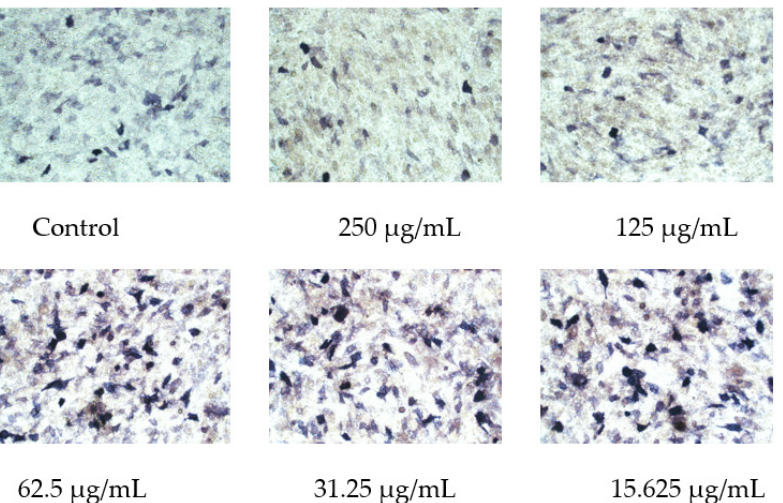
Figure 10. Effect of osmanthus fragrans extract on ALP staining of MC3T3-E1. ALP staining was performed after MC3T3-E1 cells were treated with different concentrations of osmanthus fragrans extract for 7 days. The coloration observed under the microscope (×20).